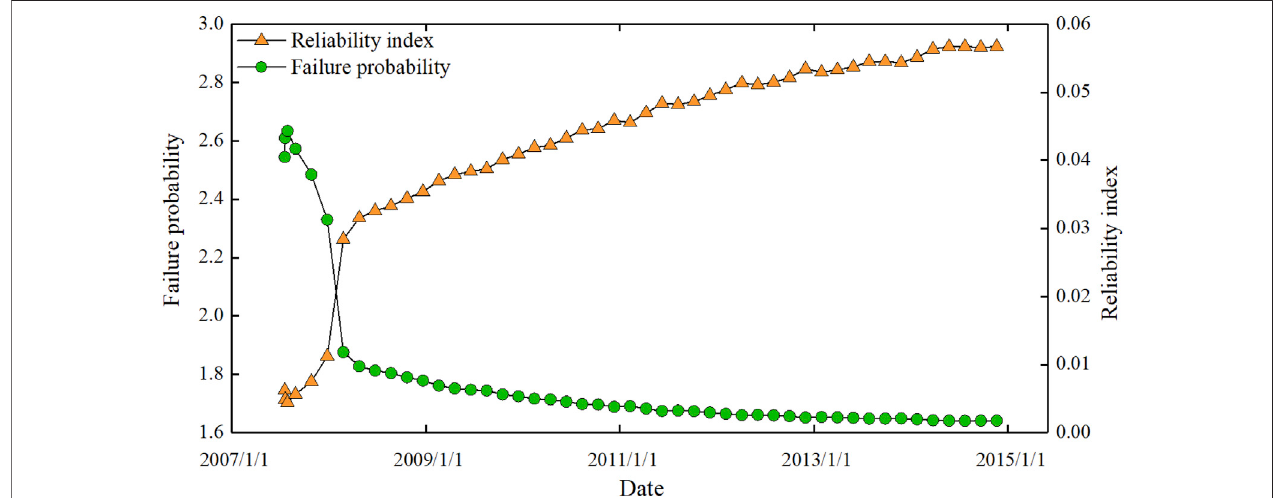
FIGURE 13 | Stability and reliability indexes of the left bank slope and the probability of failure over time curve.